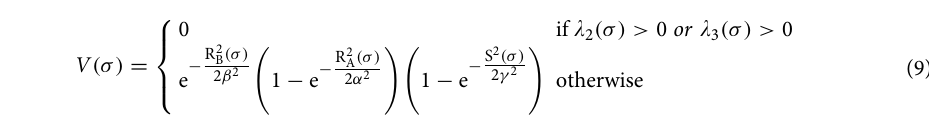
Figure 5. Block scheme representing the main computational steps of the Frangi filter. In the present application, the estimation of the vesselness probability function over different spatial scales was parallelized for efficiency’s